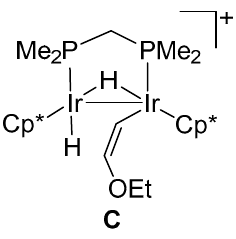
Figure 5. Structure of intermediate C .